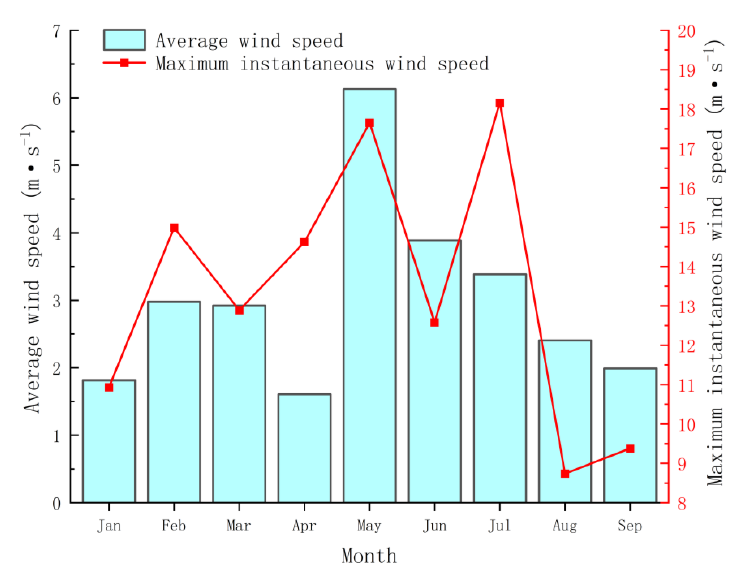
Figure 9. Wind speed characteristics of reservoirs in the test